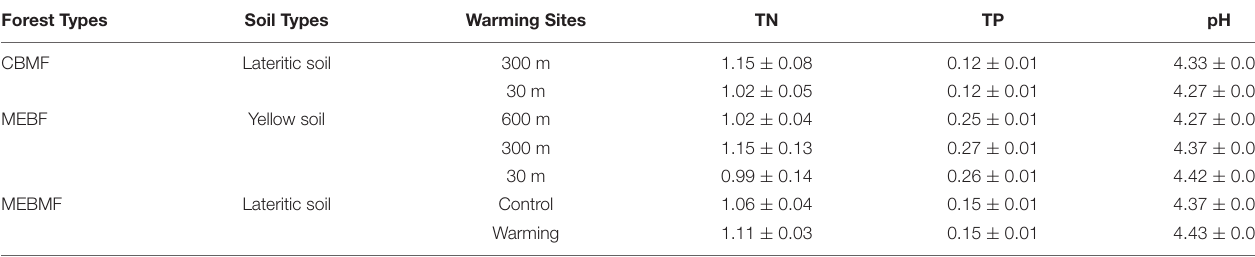
TABLE 2 | The soil types, concentrations of total nitrogen (TN, g kg − 1 , n = 9) and phosphorus (TP, g kg − 1 , n = 9), and pH in the substrate soil (0–10 cm) in the wet season from 2017 to 2019 for coniferous and broadleaf forest (CBMF), mountain evergreen broadleaf forest (MEBF) and monsoon evergreen broadleaf forest (MEBMF). Forest Types